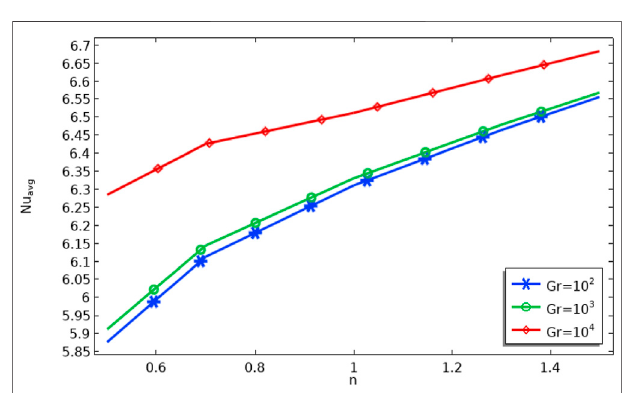
FIGURE 8 | Impact of n on Nu avg for different values of Gr .